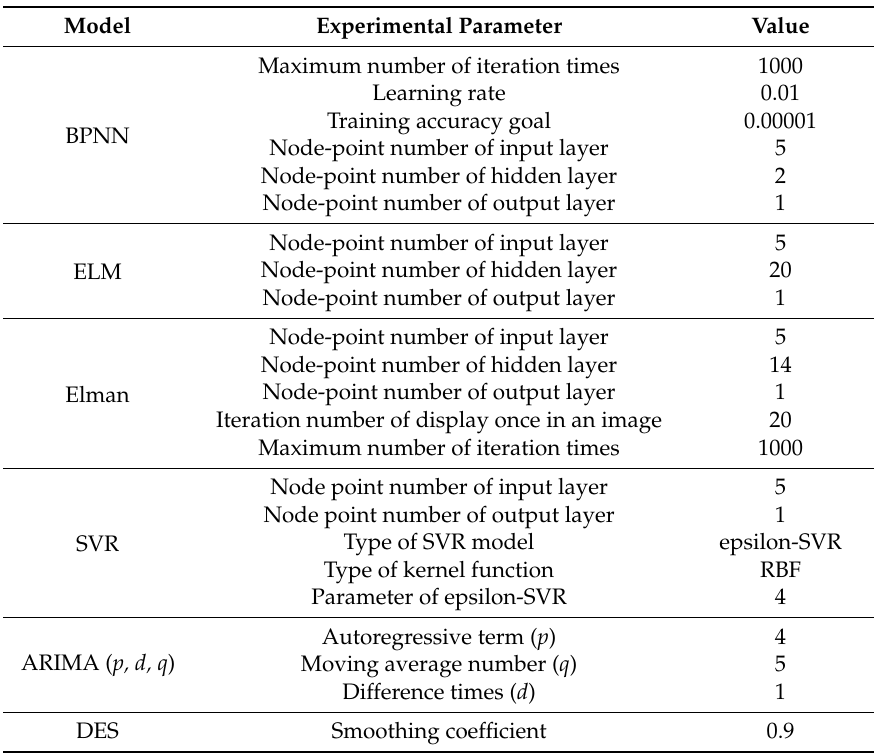
Table 8. Experimental parameter values in different